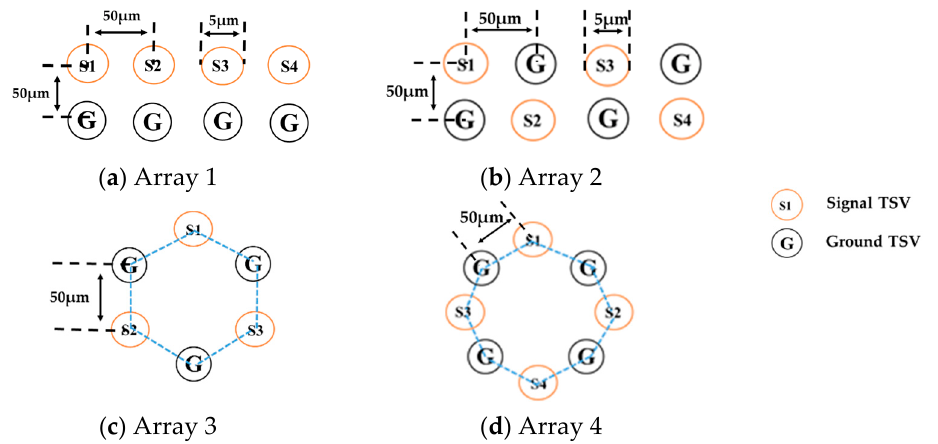
Figure 3. Three TSV arrays: ( a ) S-S layout, ( b ) G-S layout, ( c ) hexagonal layout, ( d ) octagonal layout. The TSV layout in Figure 4 is used to characterize the function of the differential signal.